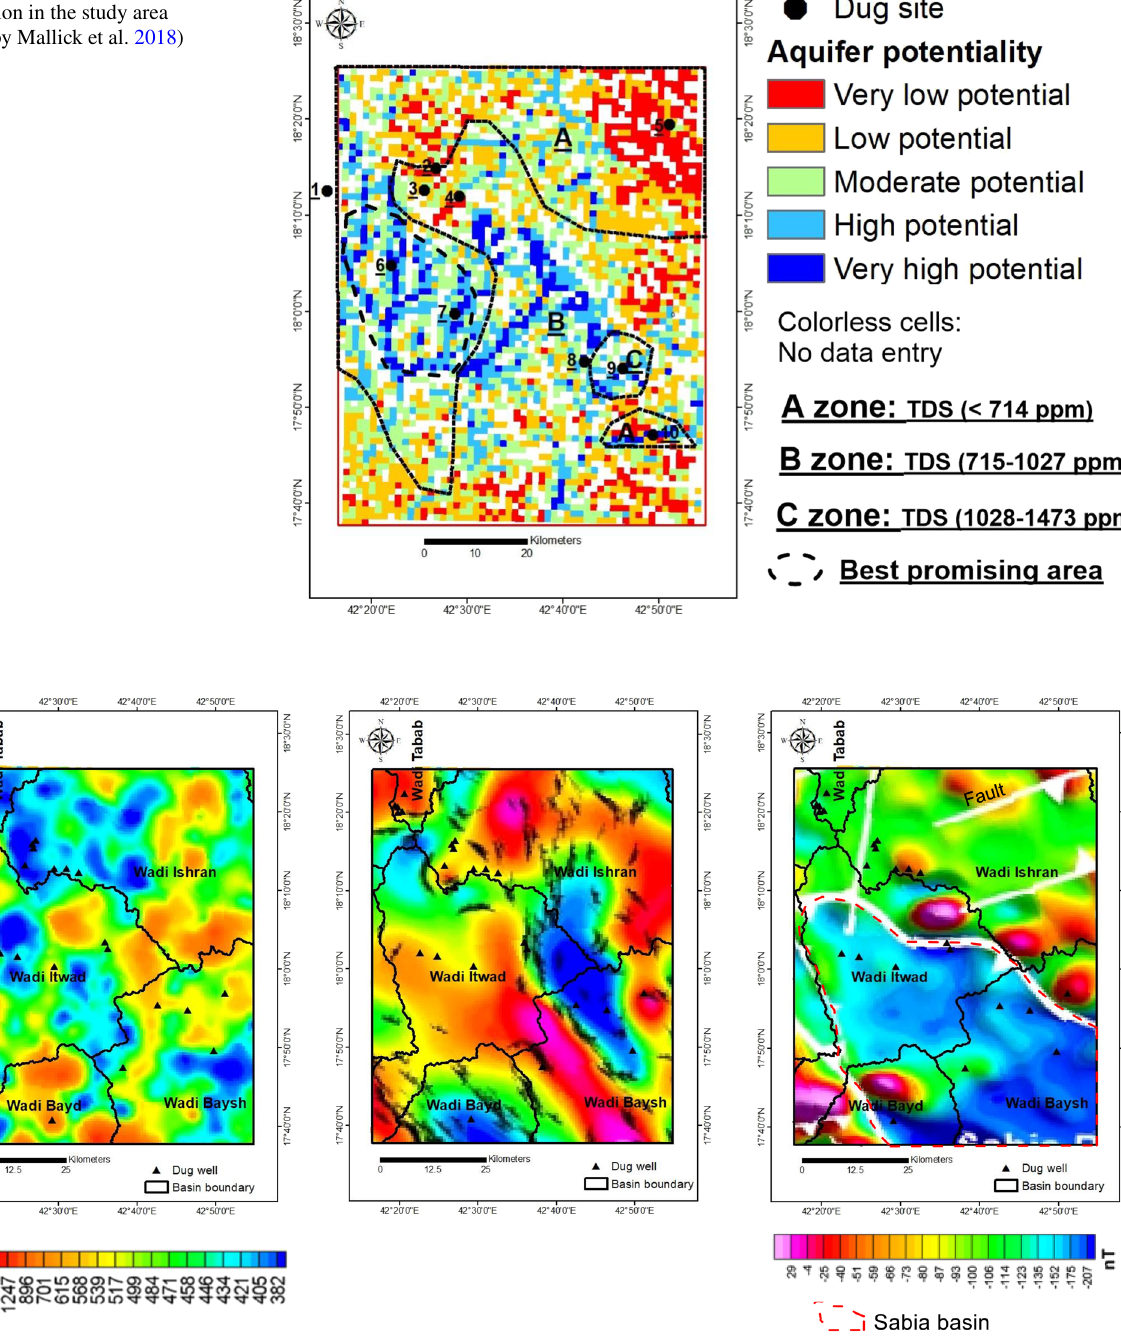
Fig. 14 Dug sites and TDS concentration in the study area (reported by Mallick et al. 2018)